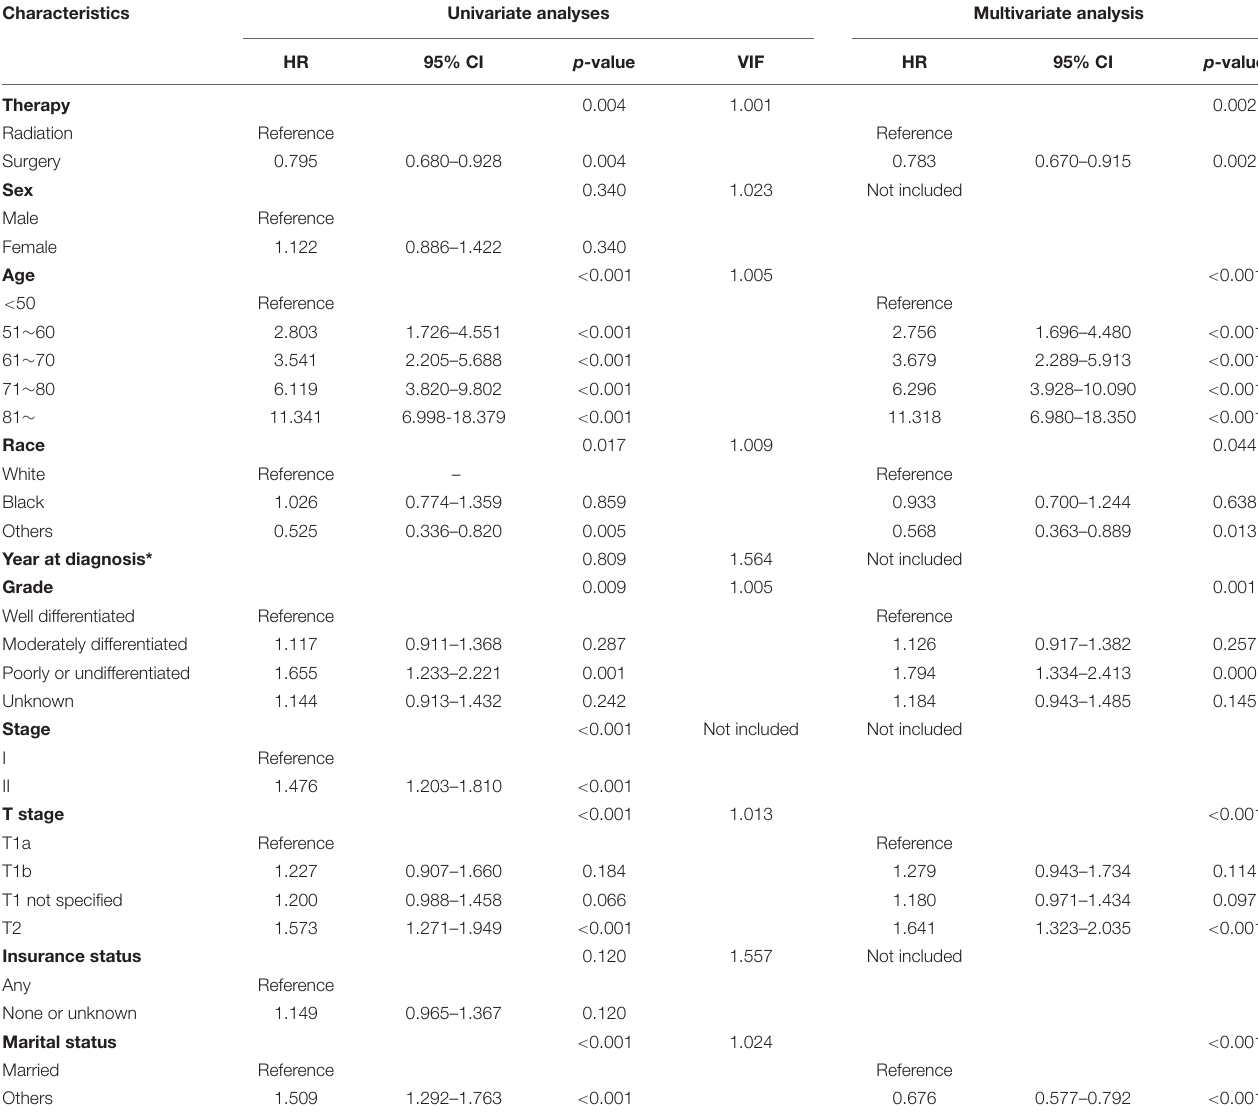
TABLE 2 | Results of univariate and multivariate analyses of cancer-specific survival after matching. Characteristics Univariate analyses Multivariate